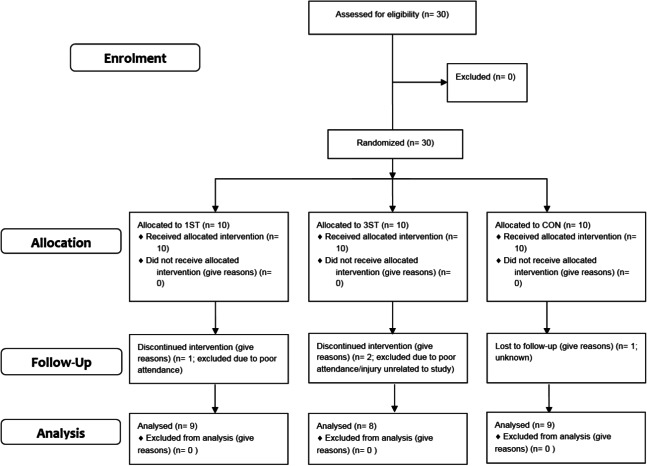
CONSORT diagram.